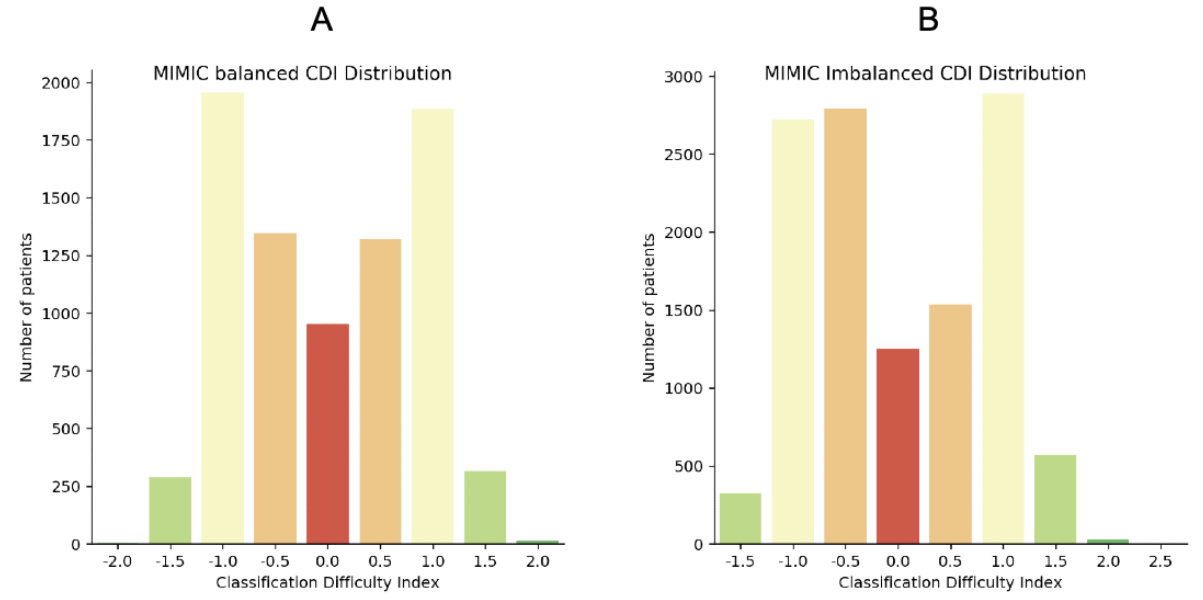
Figure 2. Classification Difficulty Indexes in MIMIC-III (A) balanced and (B) imbalanced data. CDI: classification difficulty index; MIMIC: Medical Information Mart for Intensive Care.